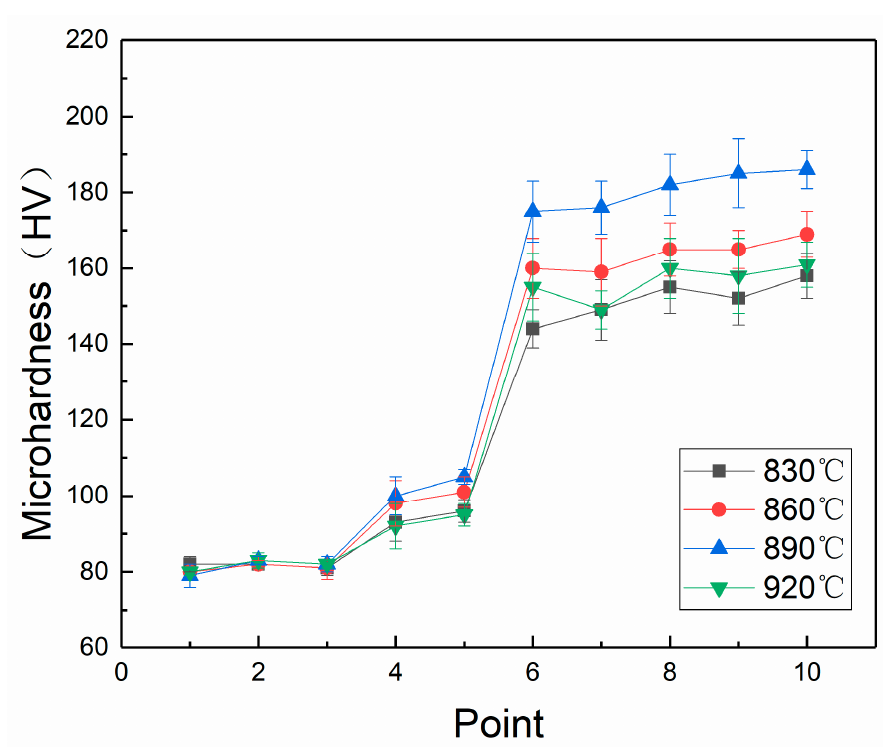
Figure 9. Linear hardness distributions.